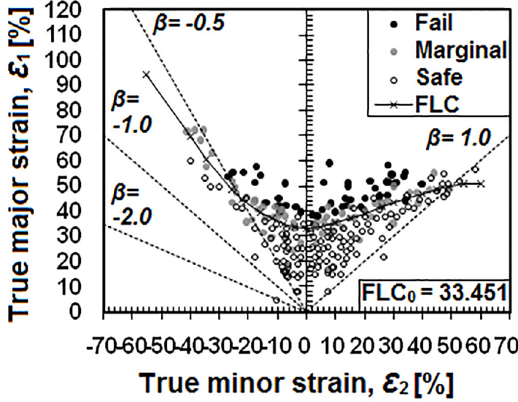
Figure 5. Graphical showing of FLD , plotted from Erichsen cup test.